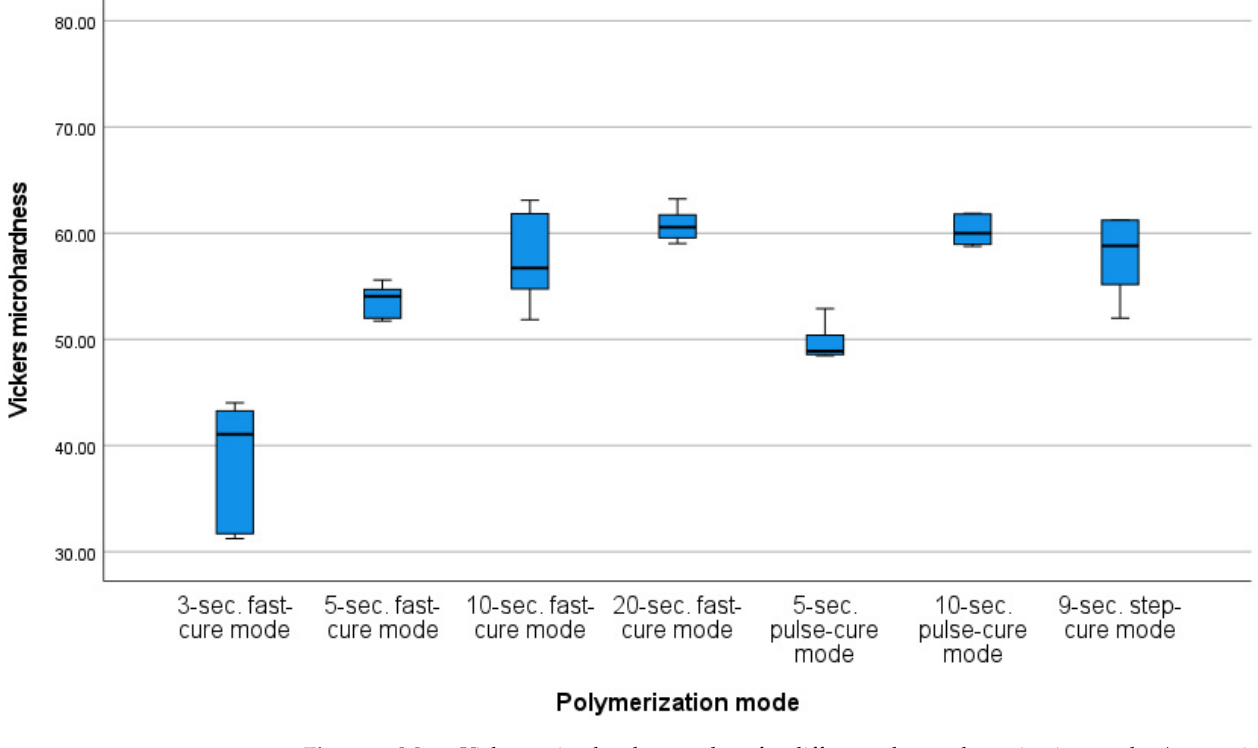
Figure 5. Mean Vickers microhardness values for different photopolymerization modes (post-ag- ing).